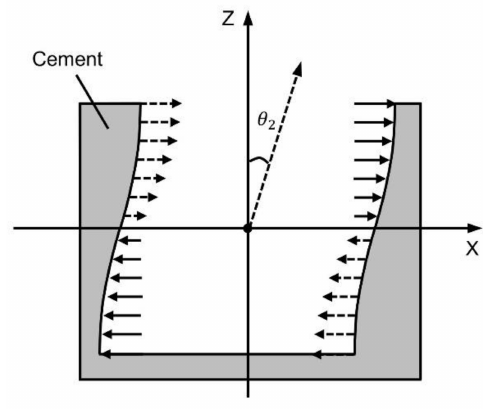
Figure 5. Contact forces on the